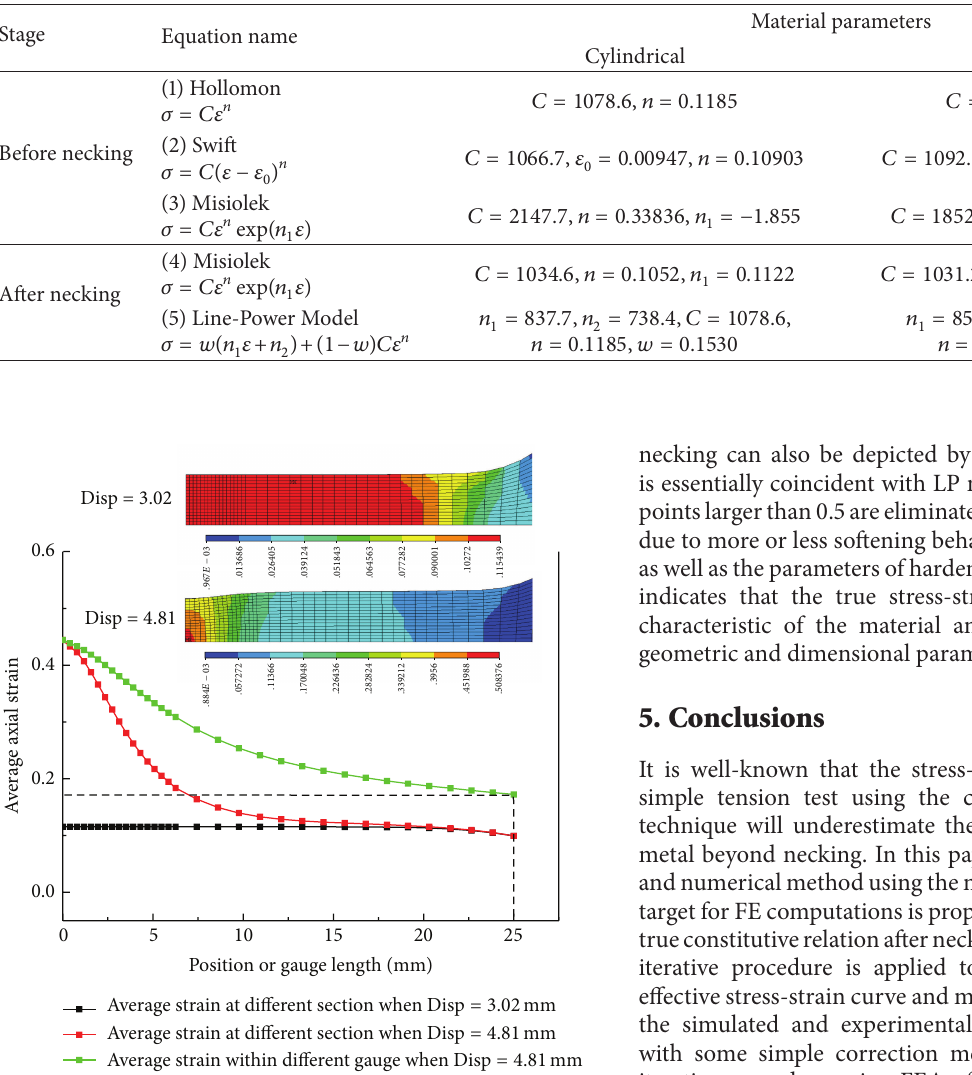
Table 3: Material parameters for experiential hardening laws.